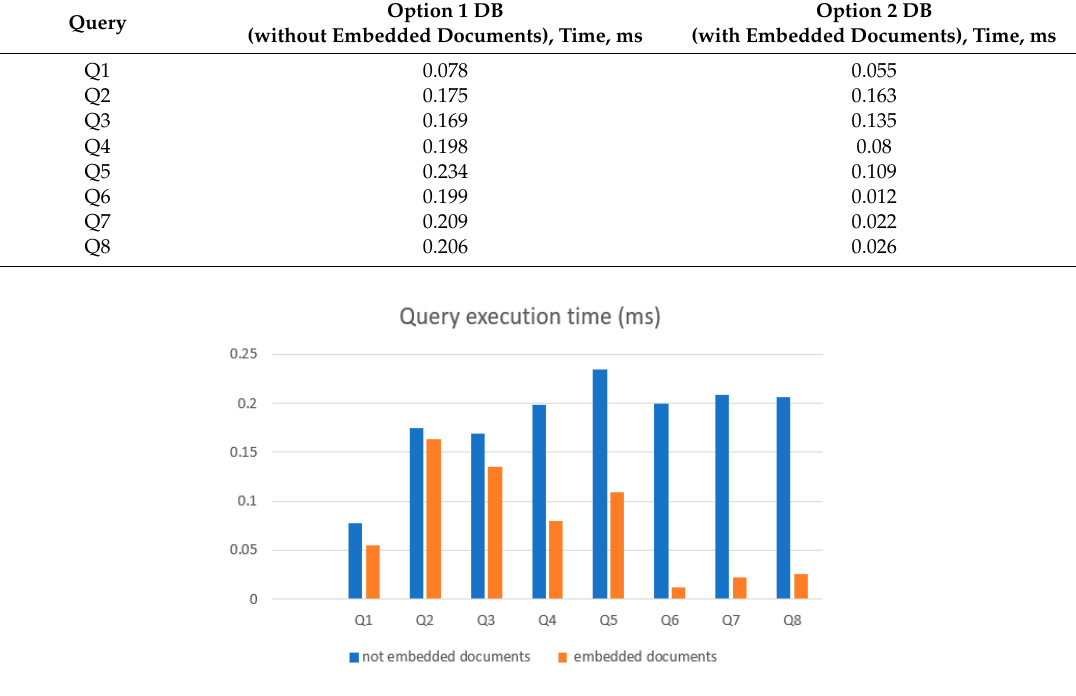
Figure 13. A diagram showing the execution time of six queries to a database of two types: a single database and a database with embedded documents. Table 4. Schematic representation of a document in a document database composed of attributes corresponding to the fields of different tables.